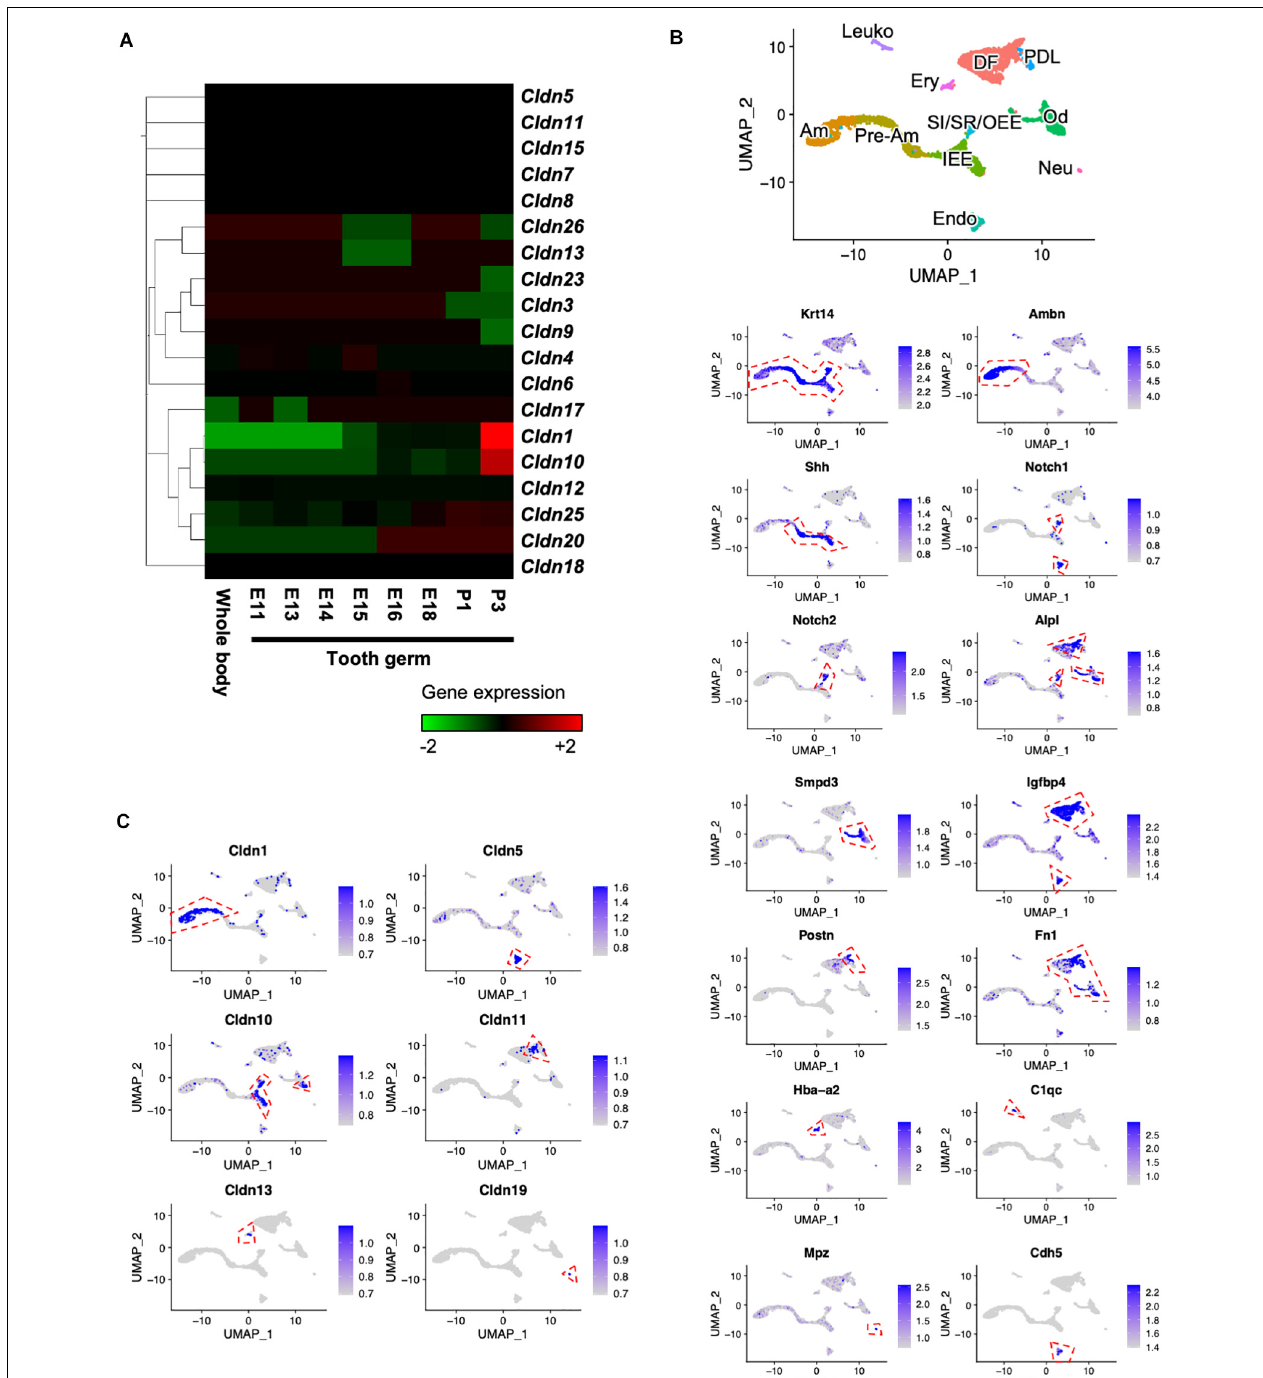
FIGURE 1 | Expression patterns of claudin family members during tooth development. (A) Heatmap of Cap Analysis Gene Expression (CAGE)-based claudin genes expression in embryonic (E) day E11 mouse whole body and tooth germs at various developmental stages. (B) Differential expression analysis of cell-type marker genes using Uniform Manifold Approximation and Projection (UMAP) visualization of single-cell datasets from postnatal (P) day P7 Krt14-RFP mouse incisors. Krt14 , epithelium marker; Ambn , ameloblast marker; Shh , IEE and pre-ameloblast marker; Notch1 and Alpl, SI markers; Notch2 , SR and OEE marker; Smpd3, odontoblast marker; Igfbp4, dental follicle and Postn , periodontal ligament markers; Fn1, mesenchyme marker; Hba-a2, erythrocyte marker; C1qc , leukocyte marker; Mpz, neural cell marker; Cdh5, endothelial cell marker. IEE , inner enamel epithelium; Pre-Am , pre-ameloblast; Am , ameloblast; SI/SR/OEE, stratum intermedium, stellate reticulum, and outer enamel epithelium; DF , dental follicle; Od , odontoblast; PDL , periodontal ligament; Ery , erythrocyte; Leuko , leukocyte; Endo , endothelium; Neu , neural cell. Red dashed lines indicate the cell cluster that highly expressed marker genes. (C) Differential gene expression analysis of claudin family members detected in single-cell datasets from P7 Krt14-RFP incisors. Red dashed lines indicate the cell cluster that highly expressed marker genes.